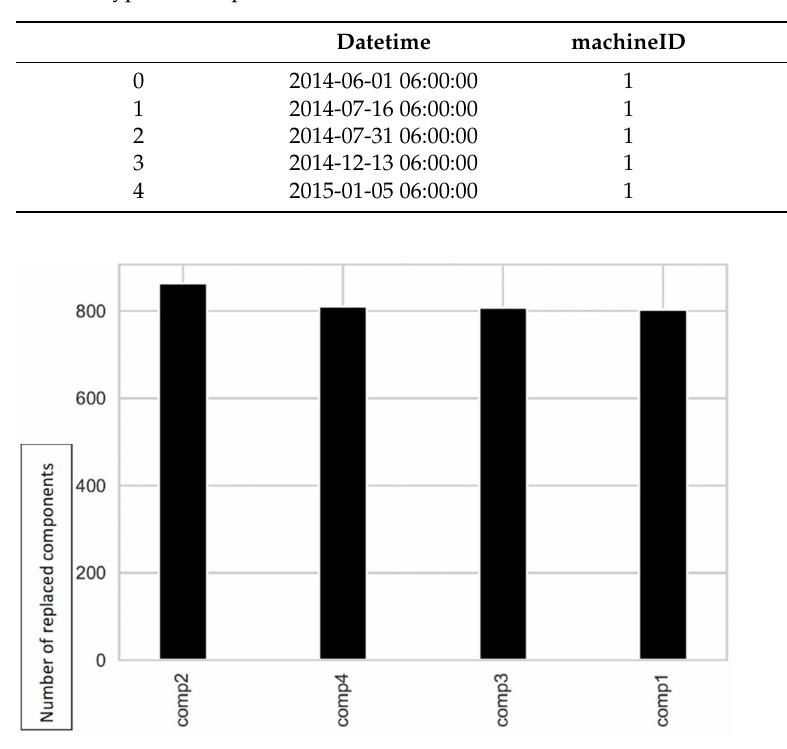
Figure 4. Representation of the number of components replaced, by